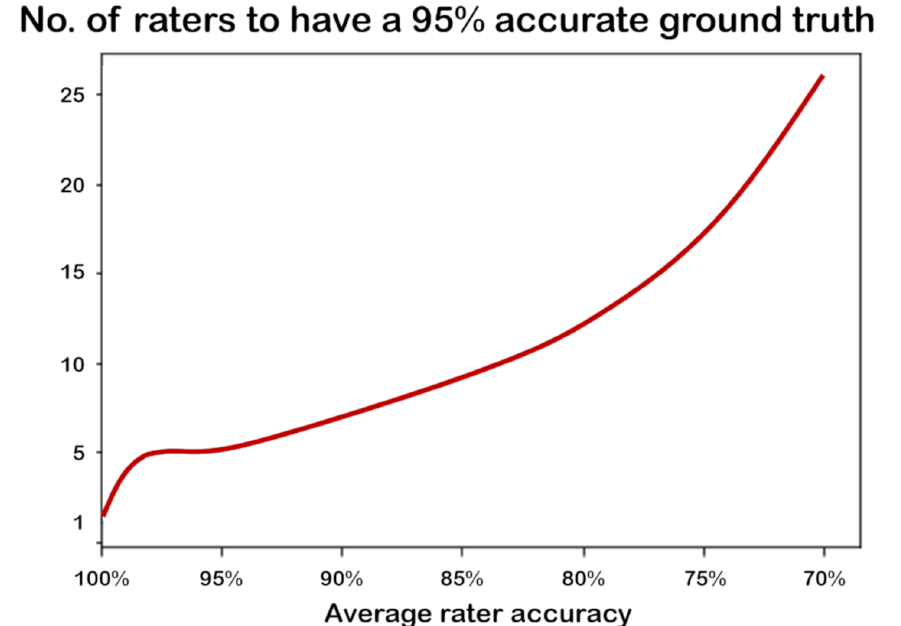
Figure 1. The figure depicts (on the y -axis) the number of raters that need to be involved to obtain a 95% accurate ground truth, as a function of the average accuracy of the raters involved (on the x -axis), if known. These estimates are obtained analytically and hence have general